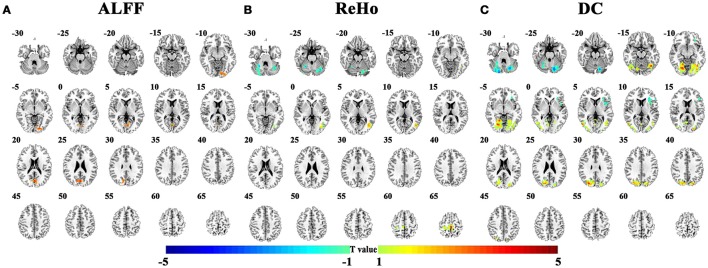
Differences of brain activity between TDC and children with ADHD on the pooled data. (A–C) indicate the results detected by ALFF (amplitude of low-frequency fluctuation), ReHo (regional homogeneity), and DC (degree centrality). The statistical threshold was set at p < 0.05, cluster size > 129 voxels, corresponding to corrected p < 0.05 determined by Monte Carlo simulation. Left in the figure indicates the right side of the brain.